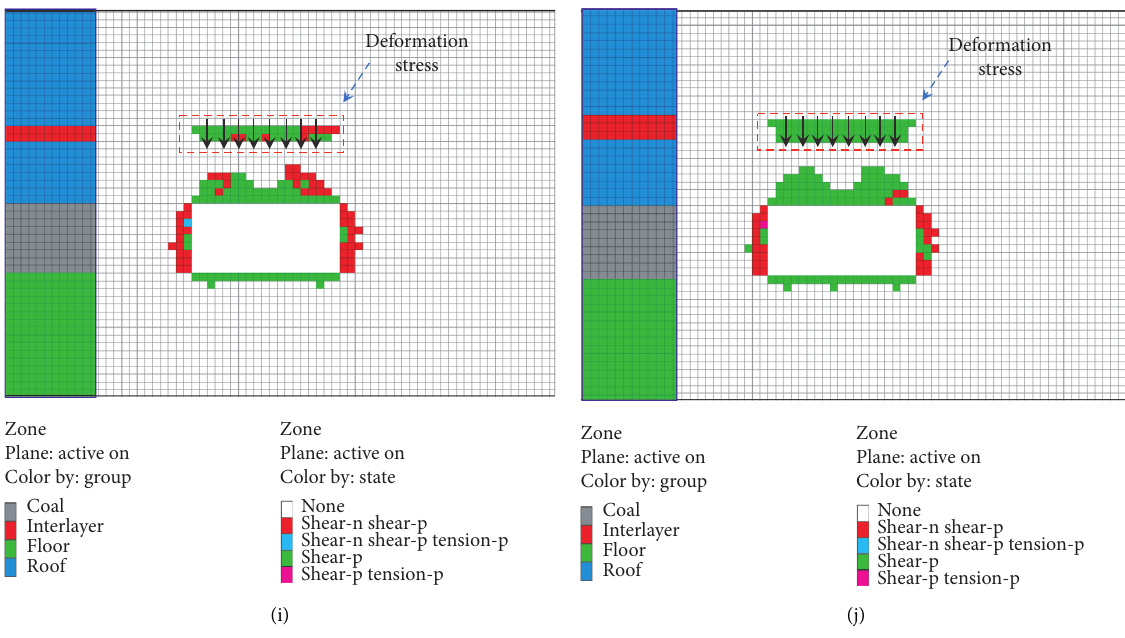
Figure 12: Influence of different interlayer states on the plastic zone. (a) No interlayers, (b) 0 m from the roof, (c) 0.8 m from the roof, (d) 2.0 m from the roof, (e) 2.4 m from the roof, (f) 2.8 m from the roof, (g) 5.6 m from the roof, (h) 2.8 m from the roof, (i) 3.2 m from the roof, and (j) 3.2 m from the